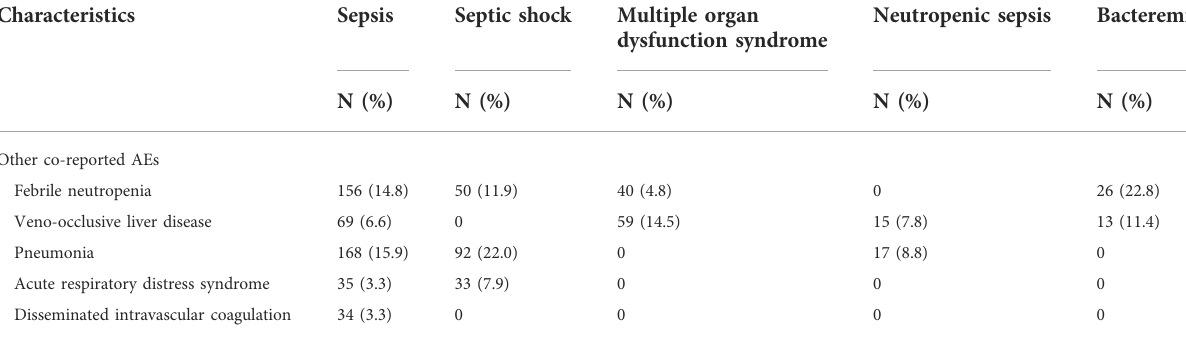
(Table 5). We analyzed the safety pro fi les for the combination therapy of ADCs with PPIs or H2-receptor antagonists. Sepsis